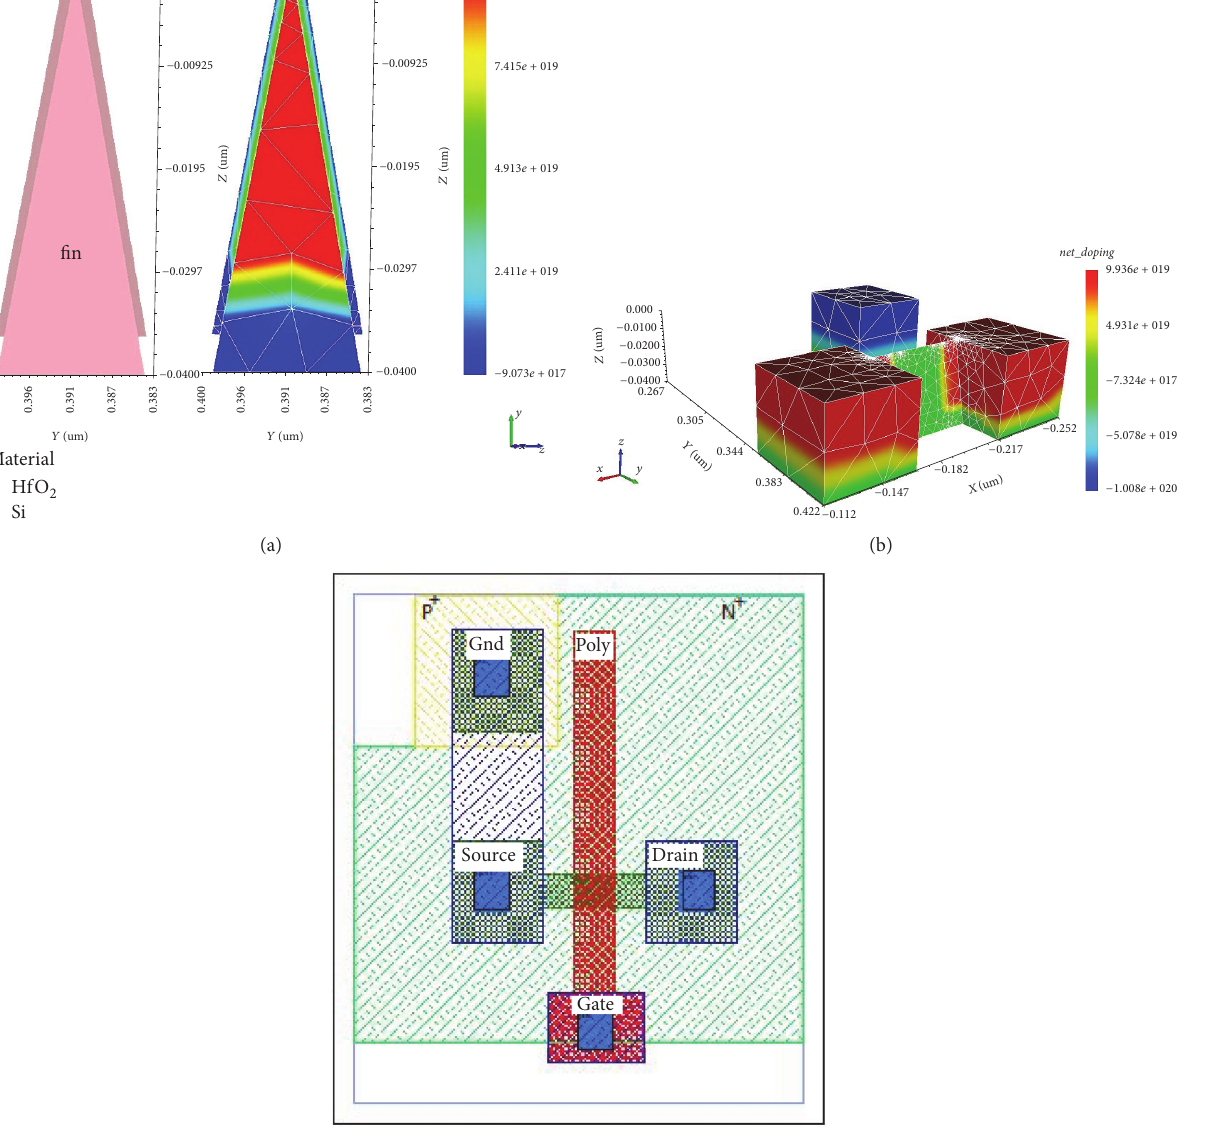
Figure 3: Triangular FinFET. (a) Triangular fin material and net doping in triangular fin. (b) Net doping in active region. (c) Mask of designed